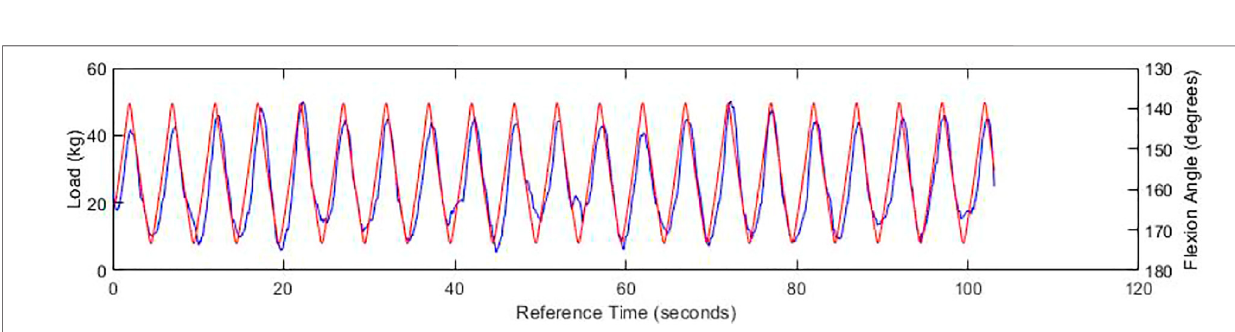
FIGURE 8 | Graph of experienced load (blue) and fl exion angle (red) at 6 V, with an SG fi ltration of the load function.